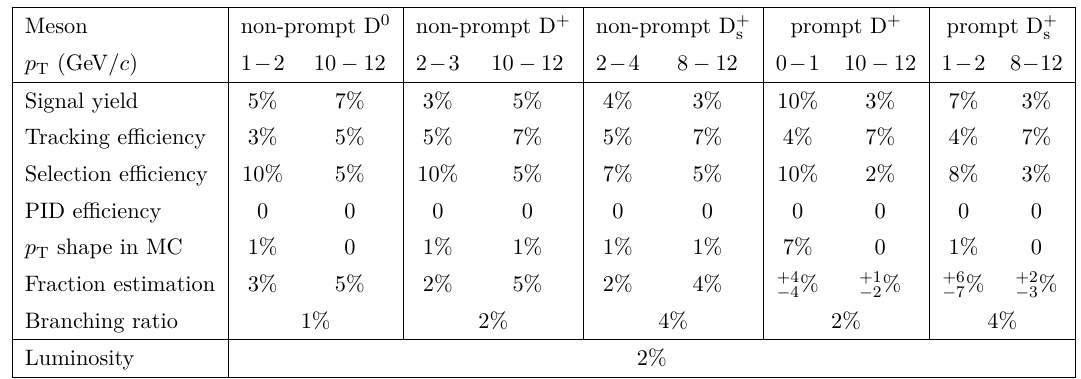
Table 1 . Summary of the relative systematic uncertainties on non-prompt D 0 , D + , and D + sections and prompt D + and D +